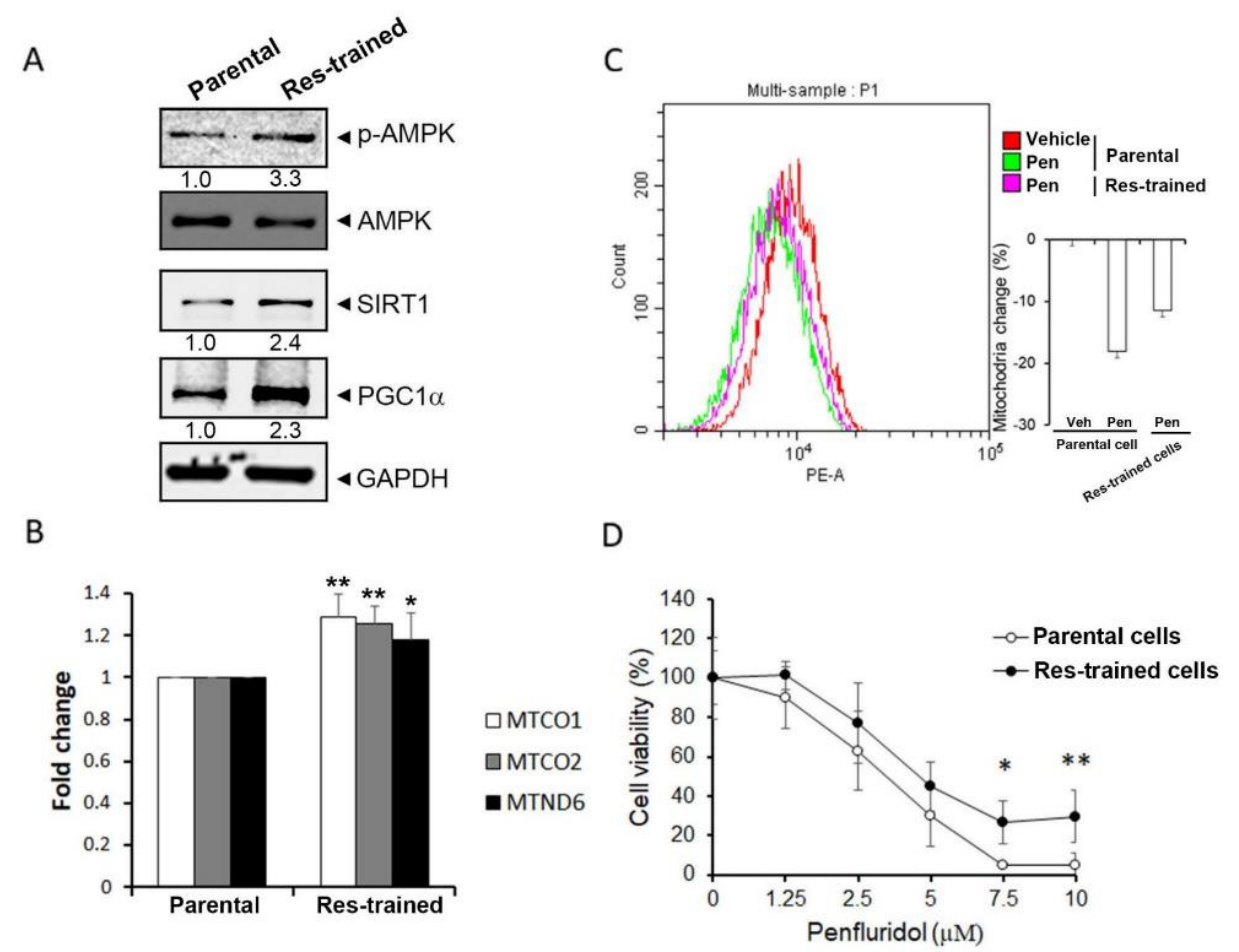
Figure 4. Upregulation of the sirtuin 1 (SIRT1)/peroxisome − proliferator − activated Figure 4 . Upregulation of the sirtuin 1 (SIRT1)/peroxisome − proliferator − activated receptor co − acti- vator −1α (PGC−1α) axis reverses penflu ridol − mediated inhibition of cell proliferation and mito- chondrial biogenesis. ( A ) A549 cells were treated with 50 µM resveratrol for 6 h per day for 3 days ylated (p) − adenosine monophosphate − activated protein kinase (AMPK), SIRT1, and PGC − 1  .